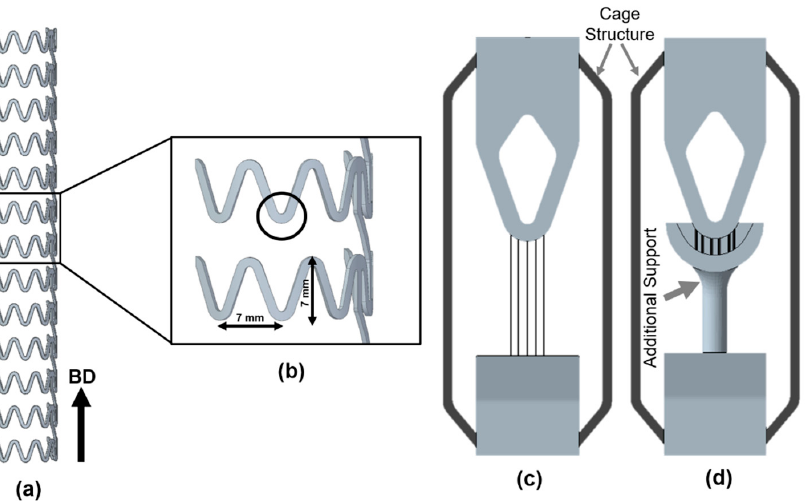
Figure 4. ( a ) The representative geometry of an aortic stent: ( b ) the location of support structures highlighted using a black circle; initial design of the representative stent geometry and the associated support structure designs including the cage structure for ( c ) line support, ( d ) cross support. An additional support structure is also shown ( d ) for the cross support.